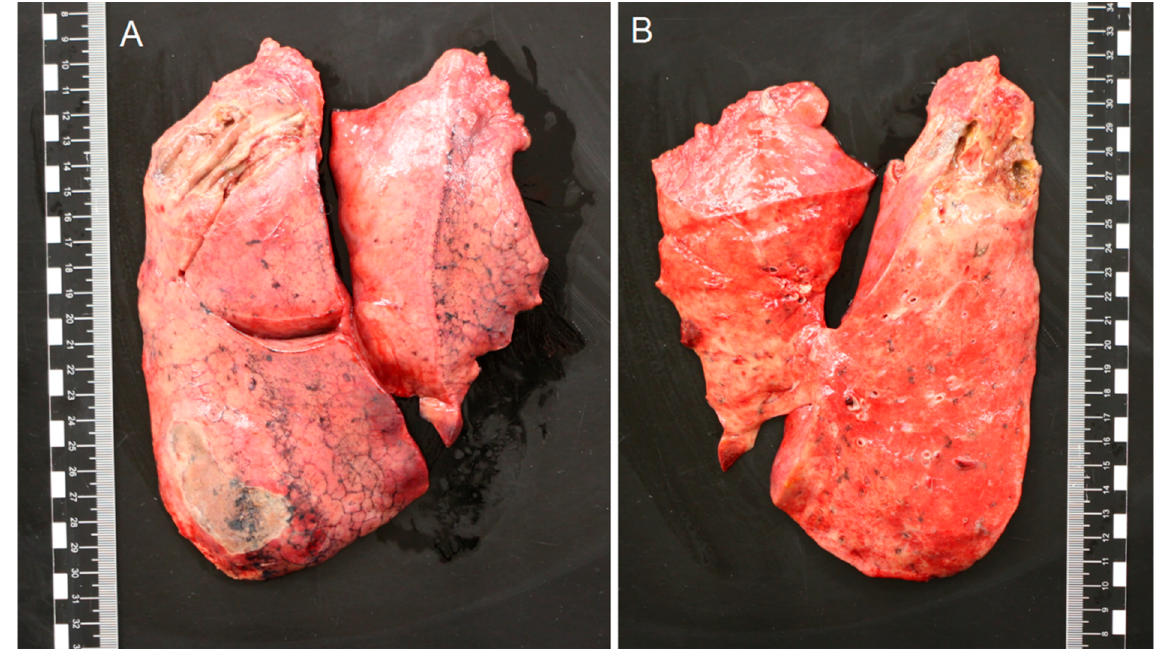
Figure 1. ( A,B ) Macroscopy of the right and left lung. All lobes showed white/yellow consolidations. In the left upper lobe, an abscess with a diameter of 2 cm and in the right upper lobe an abscess of 6.5 cm were found, both filled with green/yellow pus. Cultures of these lesions showed growth of Aspergillus fumigatus .